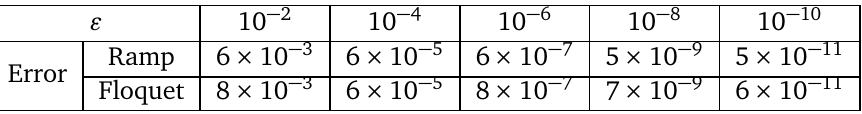
Table 2: Error of the Green’s functions compared with the direct method, maximized over all Keldysh components, for different (cid:34) . For both examples, T = 64, N = 4096, and M = 128.